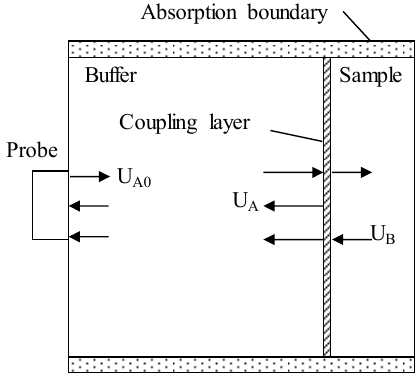
Figure 5. Schematic diagram of the simulation model by the PZflex method and wave propagation process with 50 μ m-thick aqueous medium and absorption boundary.